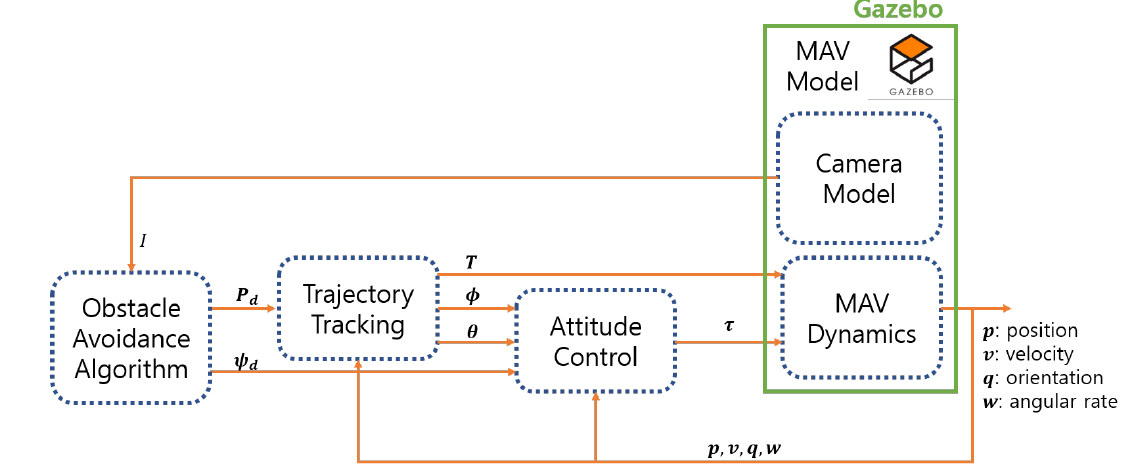
Figure 7. Obstacle avoidance simulator